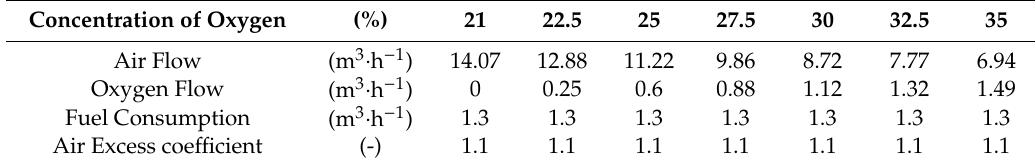
Table 3. Volumetric flows of inlet media depending on oxygen concentration in the oxidizing agent.